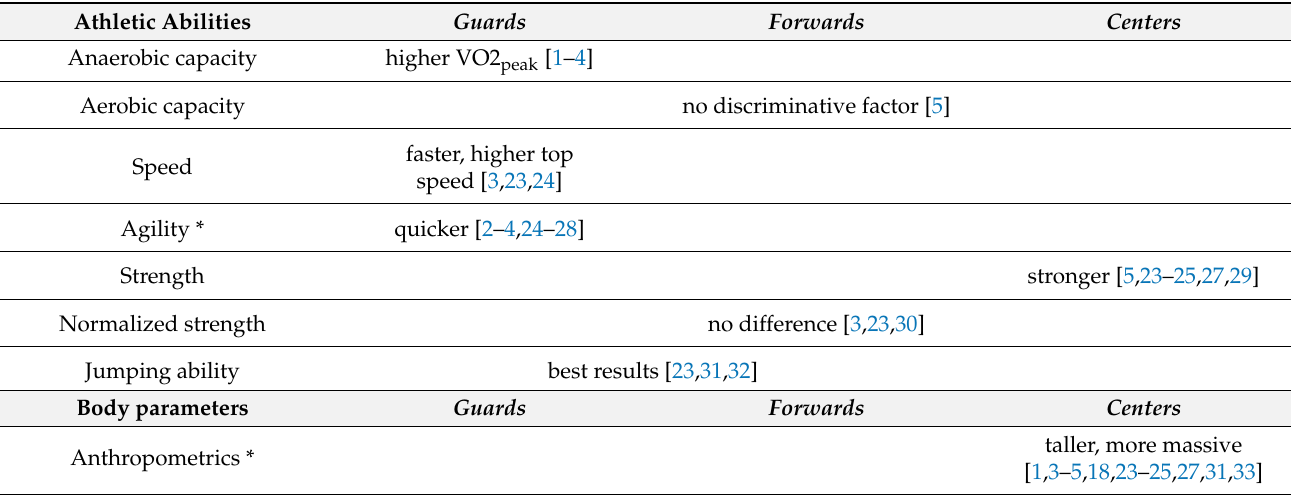
Table 1. Differences in test results, athletic abilities, and body parameters between players in different positions. Athletic